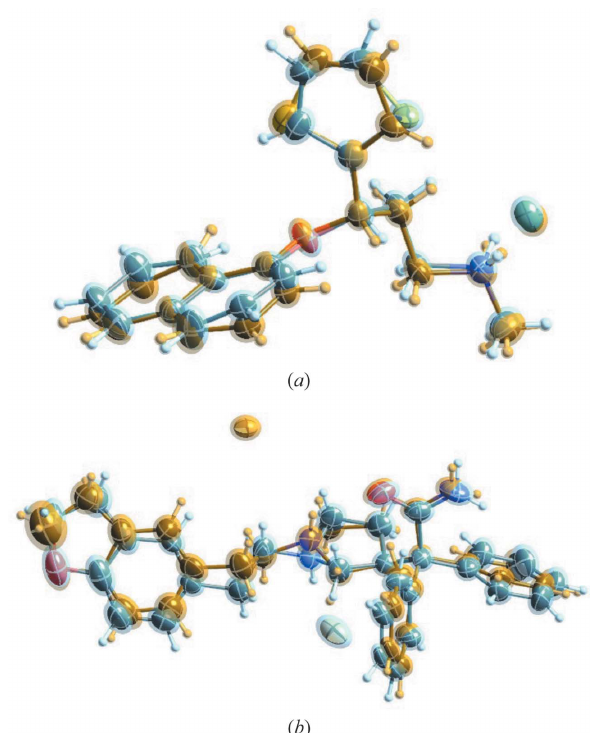
Figure 6 Displacement ellipsoid representations of the structures of duolexetine hydrochloride [CSD refcode MUCDUK, ( a )] and darifenacin hydro- bromide [CSD refcode SOYMID, ( b )] from restrained/constrained refinements. In these two cases, only the overall shape of the molecules superpose well. Disordered parts of the different conformations of the molecules are highlighted again. The illustrations were generated with SHELXLE (Hu¨bschle et al. , 2011).